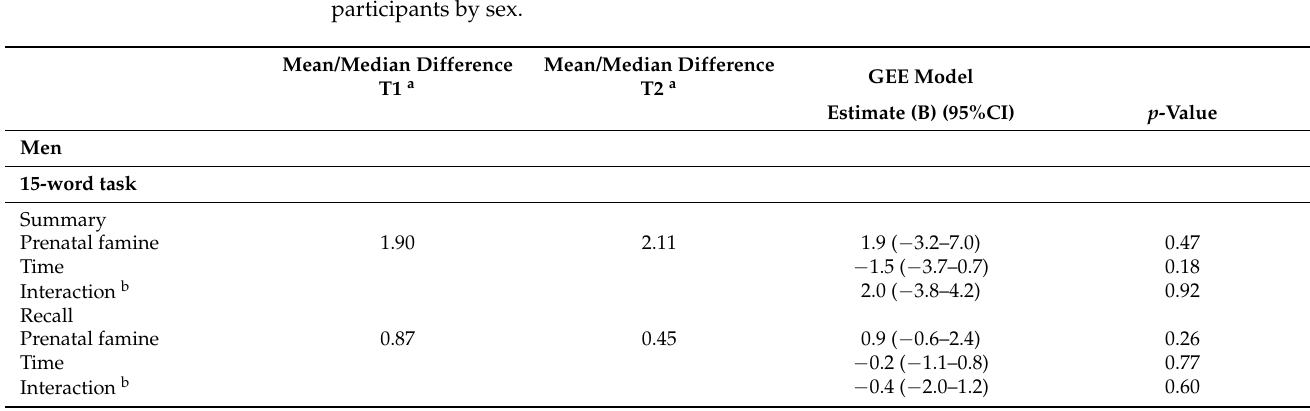
Table 5. Generalized estimation equation (GEE) models with ‘exposure × time’ interaction terms comparing cognitive outcomes between participants prenatally exposed to famine and unexposed participants by